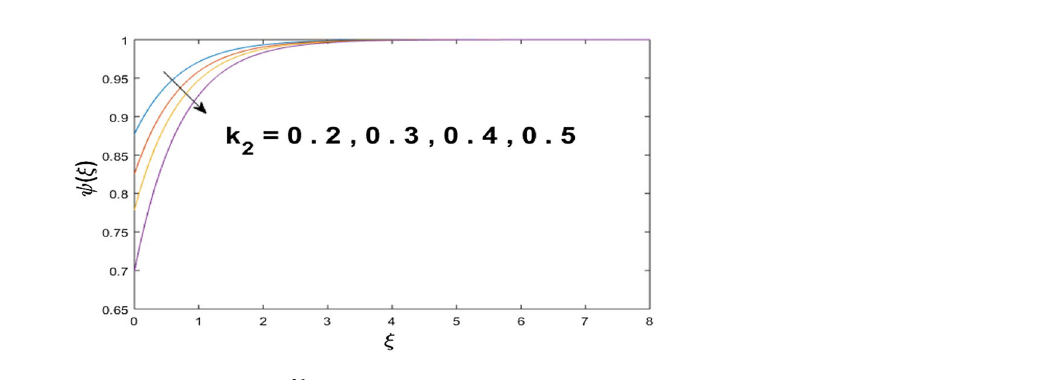
Figure 14. Variations of k 2 to ψ(ξ)